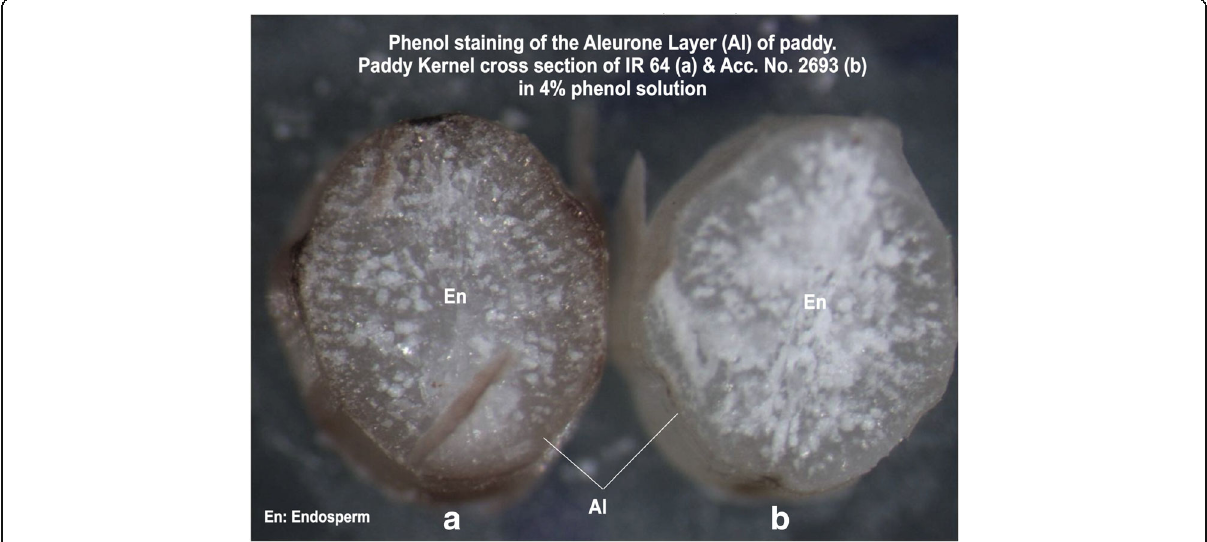
Fig. 1 Cross section of rice kernel derived from IR 64 (coloured) and Acc. No. 2693 after subjection to phenol test. Phenol staining of the Aleurone Layer (AL) of paddy. Paddy Kernel cross section of IR 64 ( a ) & Acc. No. 2693 ( b ) in 4% phenol solution